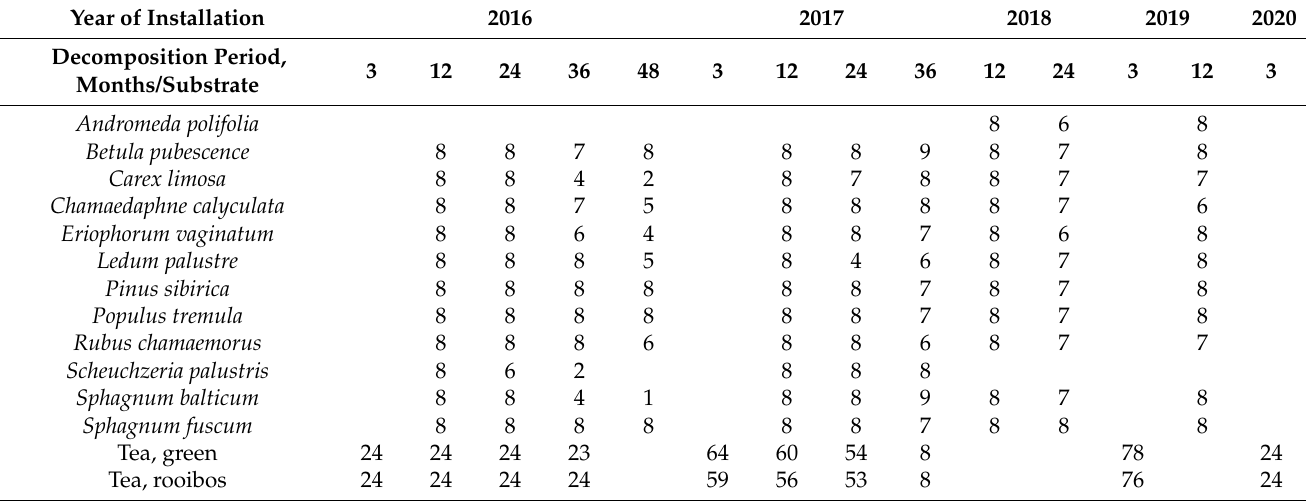
Table A3. Total number of extracted litter bags of each type in decomposition dynamics experiment in Mukhrino FS by decomposition periods and years of installation extracted by spring